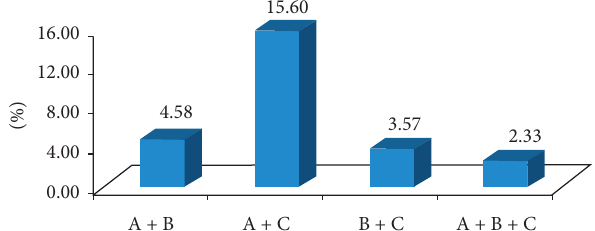
Figure 1: The overlap of hypertension, diabetes, and dyslipidemia in Northwest China. Note. A is hypertension, B is diabetes, and C is dyslipidemia. The percentages shown in each part of the figure are the proportion of the diseases in the